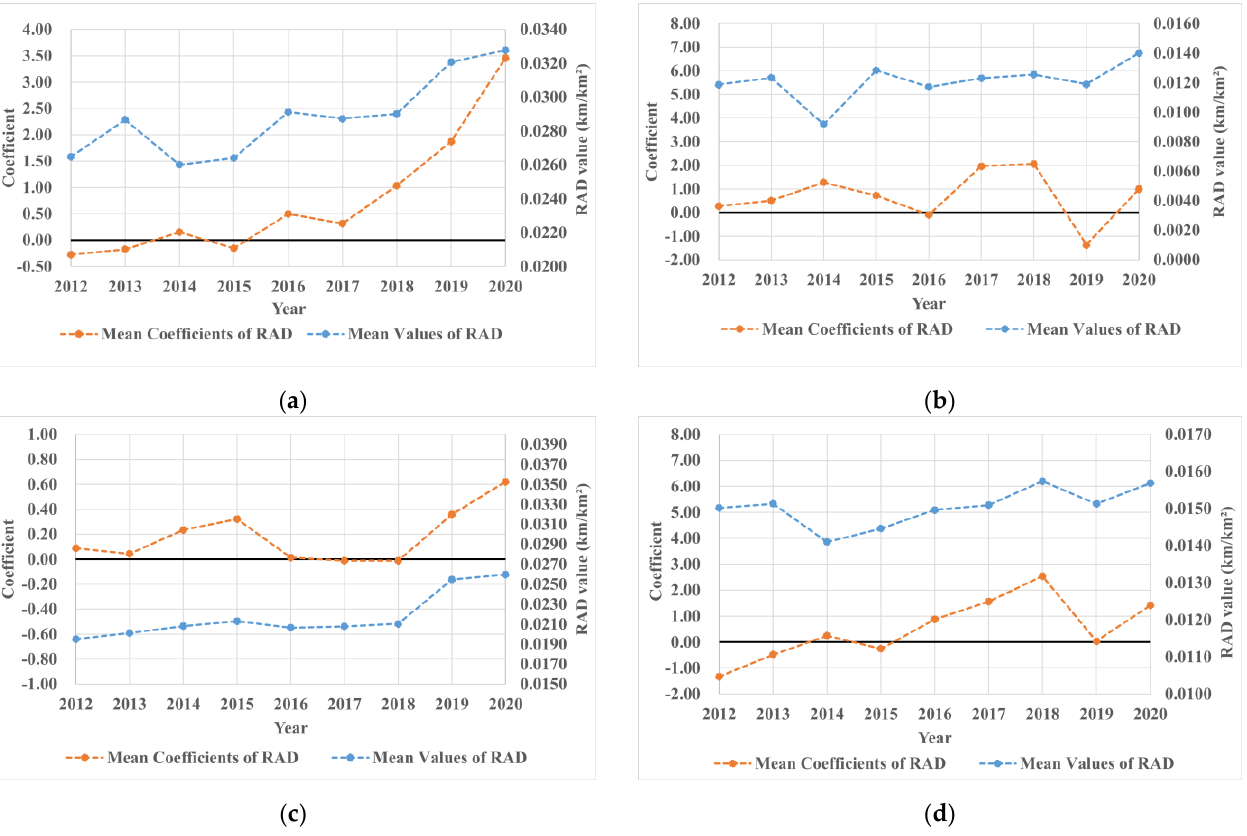
Figure 12. Temporal trends of mean RAD values and mean RAD coefficients in ( a ) Xuancheng; ( b ) Anqing; ( c ) Huangshan; ( d ) Anqing.